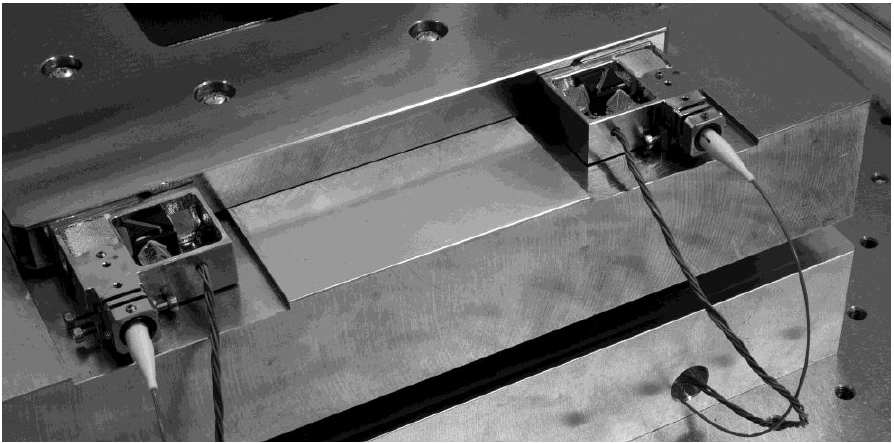
Figure 3. Photo of a pair of the interferometer units with homodyne detection, adjustment screws and fiber light